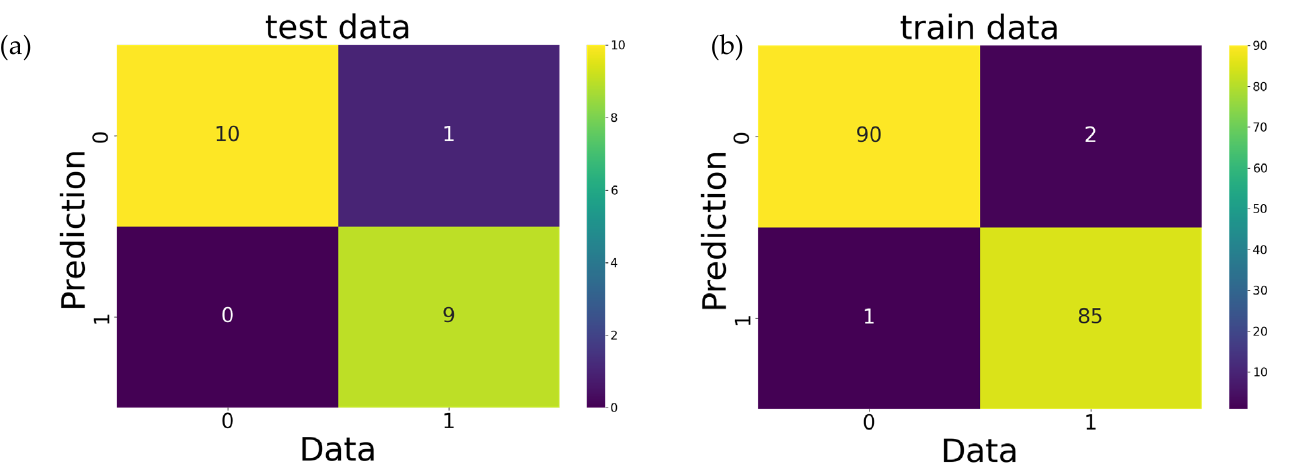
Figure 2. Prediction results at five regression tasks. The orange markers show training data, whilst the blue ones show the prediction of test data. The blue lines indicate where the plots are located when the predictions were correct. ( a ) The prediction performance when the ORAC dataset was used. ( b ) The prediction of SOAC values. ( c ) The prediction of MTT values. ( d ) The prediction of TEAC values included in the ABTS dataset.